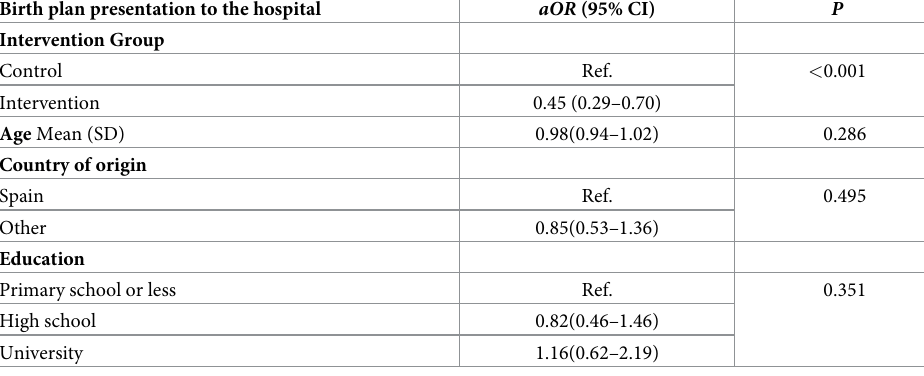
Table 5. Analysis of demographic factors related to the birth plan presentation and intervention group. Multino- mial logistic regression